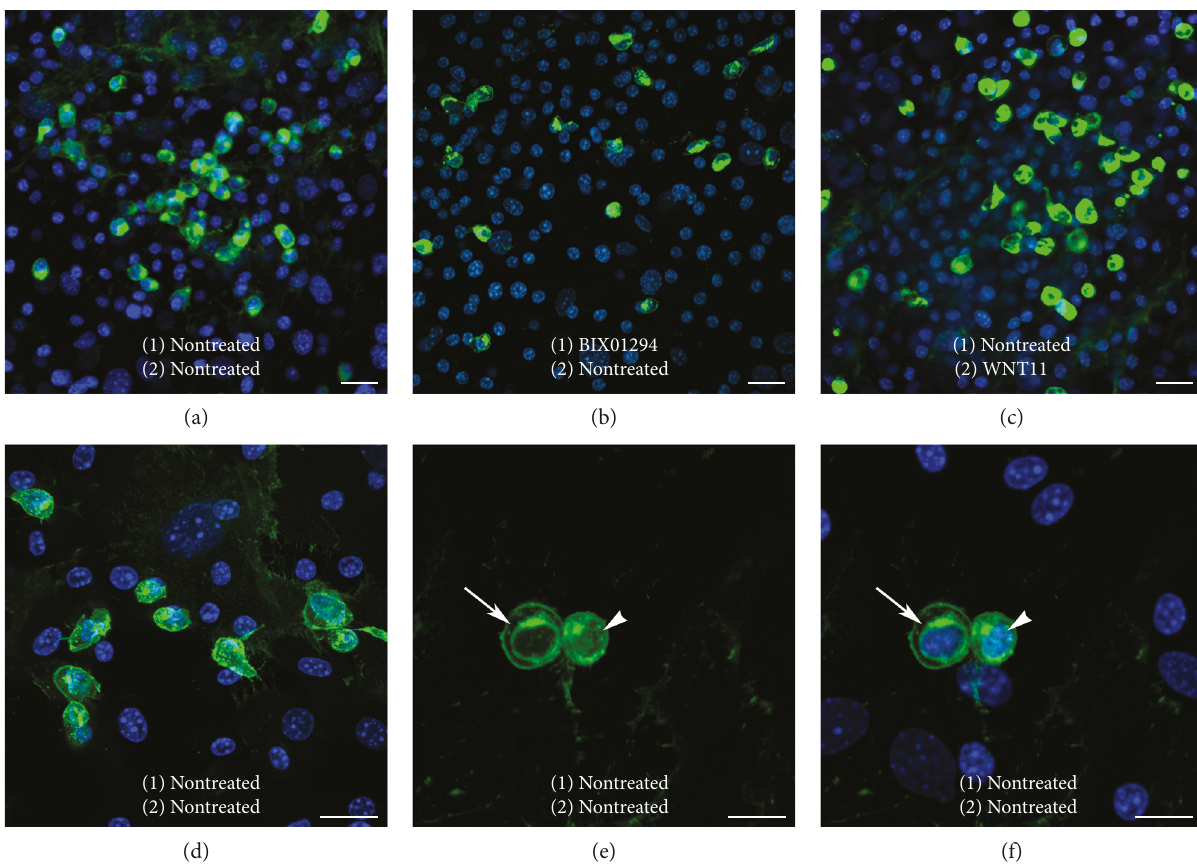
Figure 7: β -catenin expression within MSCs cultures. MSCs were immunostained for β -catenin (green) and nuclear counterstained with DAPI (blue), following a two-step protocol that involved the culturing of cells (1) for 2 days in the absence or presence of BIX01294 and then (2) for an additional 2 days with or without Wnt11. (a) MSCs cultured without treatment contained many brightly stained β - catenin-positive cells. (b) Cultures treated with BIX01294 without Wnt11 or (c) with Wnt11 without pretreatment also displayed many brightly stained β -catenin-positive cells. (d) – (f) Higher magni fi cation views of nontreated MSCs revealed the pattern of β -catenin fl uorescence within these cells. (e), (f) High resolution of brightly stained β -catenin-positive cells shown in successive panels for β -catenin immunoreactivity only or both β -catenin and DAPI fl uorescence, indicated that β -catenin protein is displayed within the cytoplasm, perinuclear region (arrow), and nucleus (arrow). Scale bar =20 μ